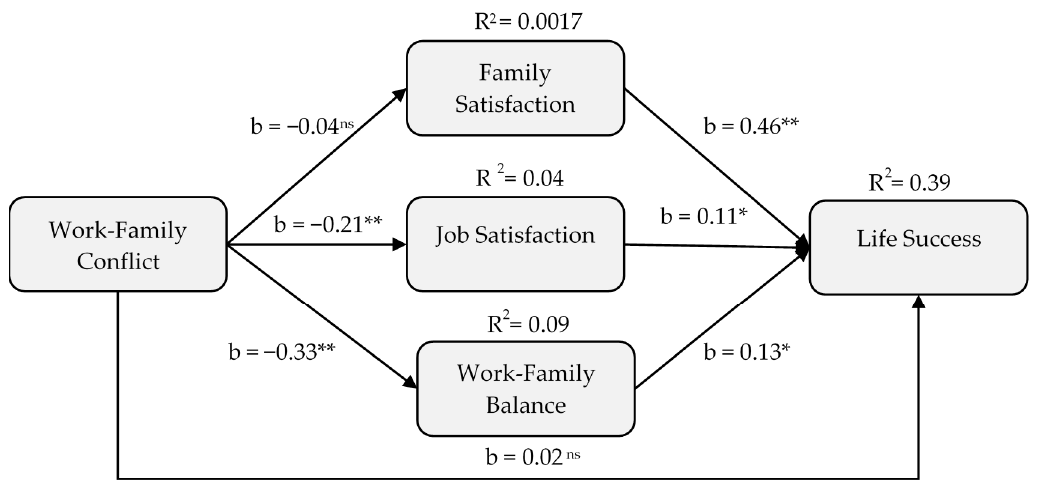
Figure 3. Mediational model on work-family conflict and life